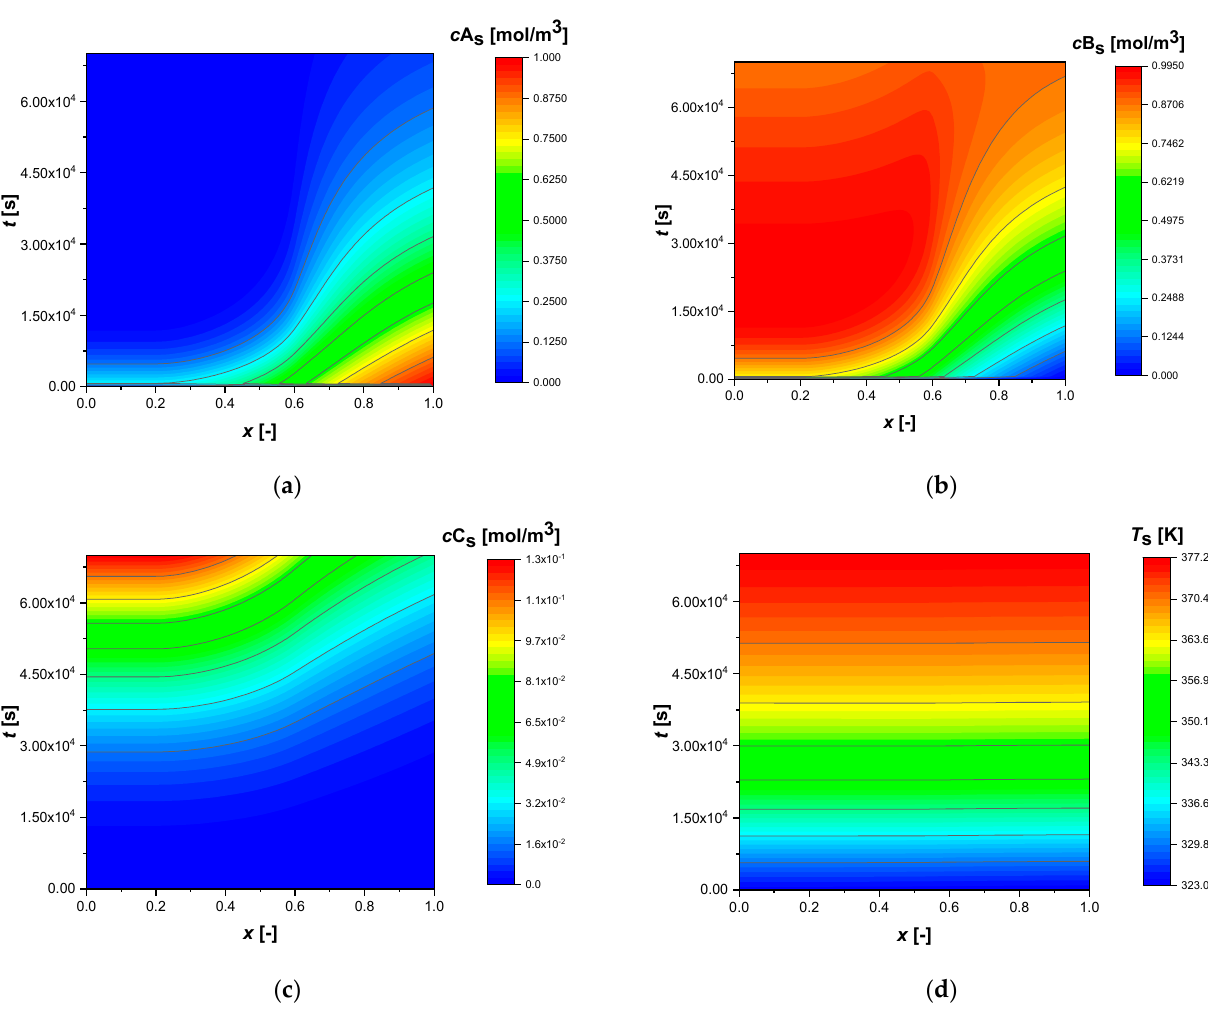
Figure 2. Intraparticle profiles for EW catalyst. Calculated profiles for: cA ( a ) , cB ( b ) , cC ( c ) and Ts ( d ). Color-bar of each plot is located on the right-hand-side.